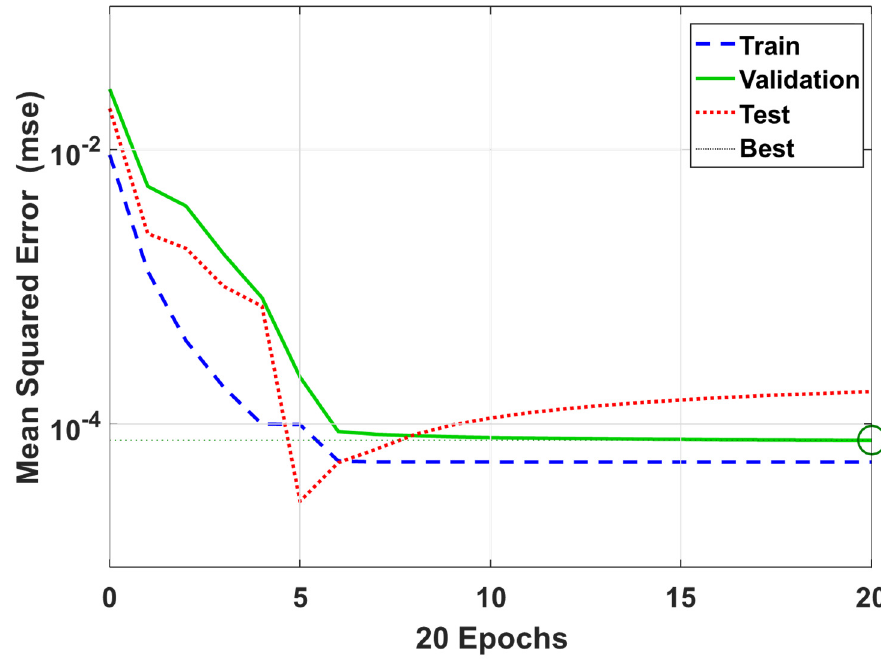
Figure 24. Training performance of proposed ECNN.